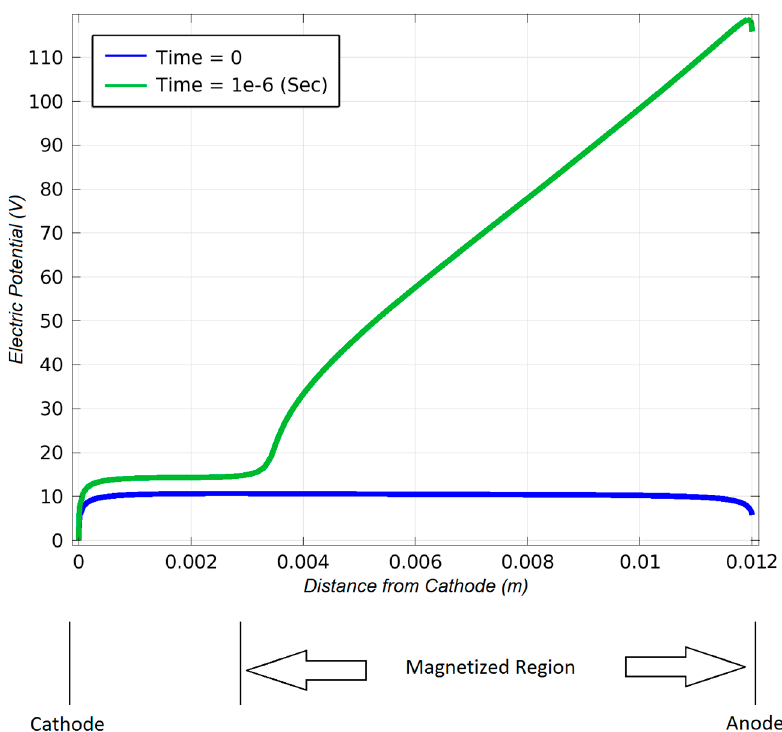
Figure 4. Distribution of the electric potential across the symmetry axis of the plasma chamber at time steps: 0 and 1 µSec after application of 1 T UFTMF.